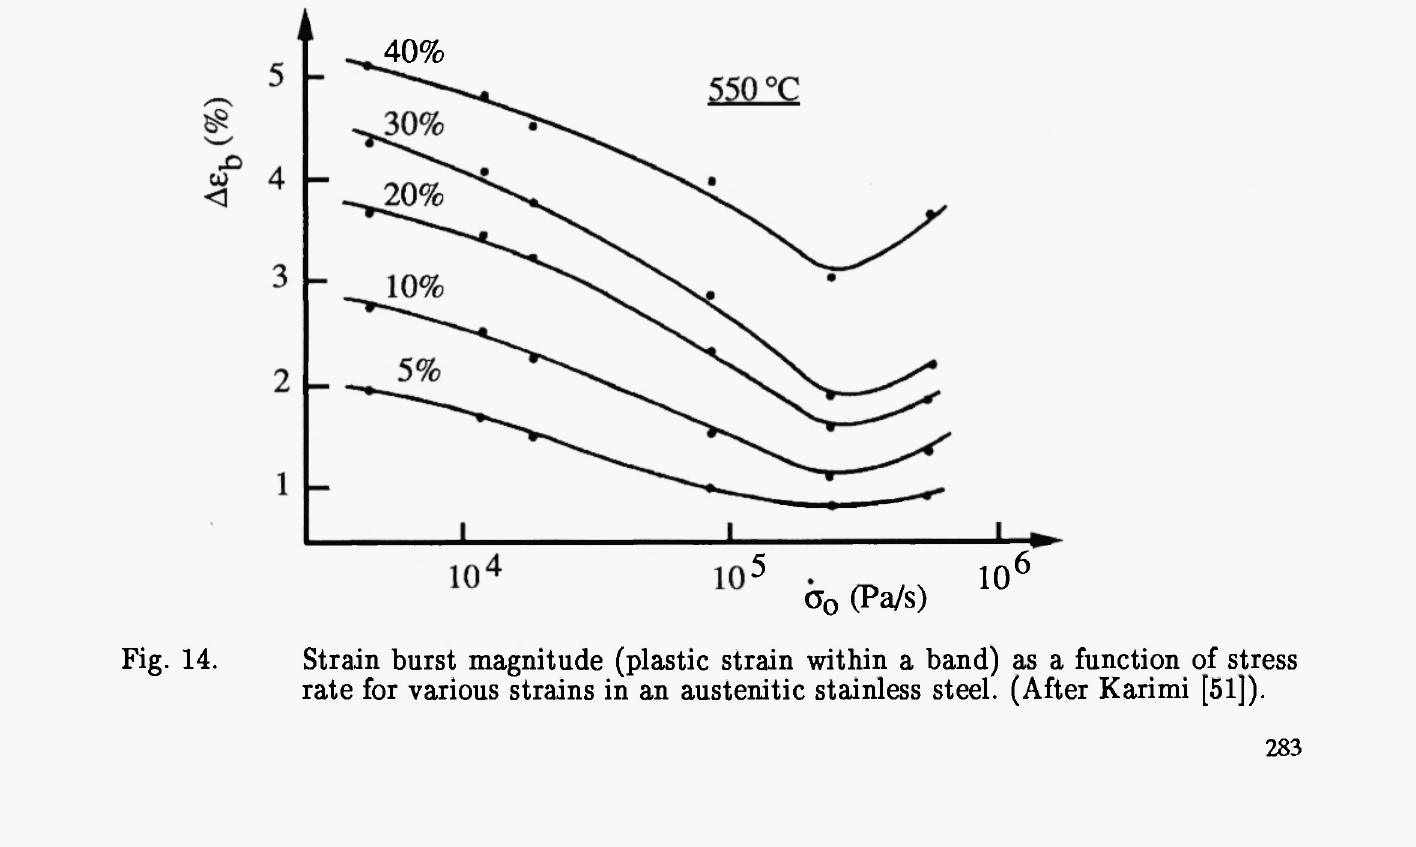
Fig. 14. Strain burst magnitude (plastic strain within a band) as a function of stress rate for various strains in an austenitic stainless steel. (After Karimi